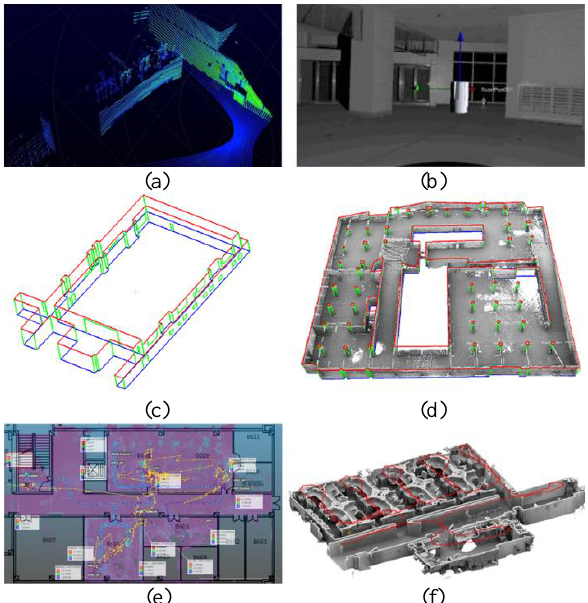
Figure 14. (a)A single frame from the LiDAR stream. (b) An indoor view of Riegl VZ 1000 data. (c) BIM structure model of a circular corridor. (d) BIM structure model with its point cloud. (e) An example of the indoor positioning benchmark. (f) The ground truth trajectory with the corresponding point